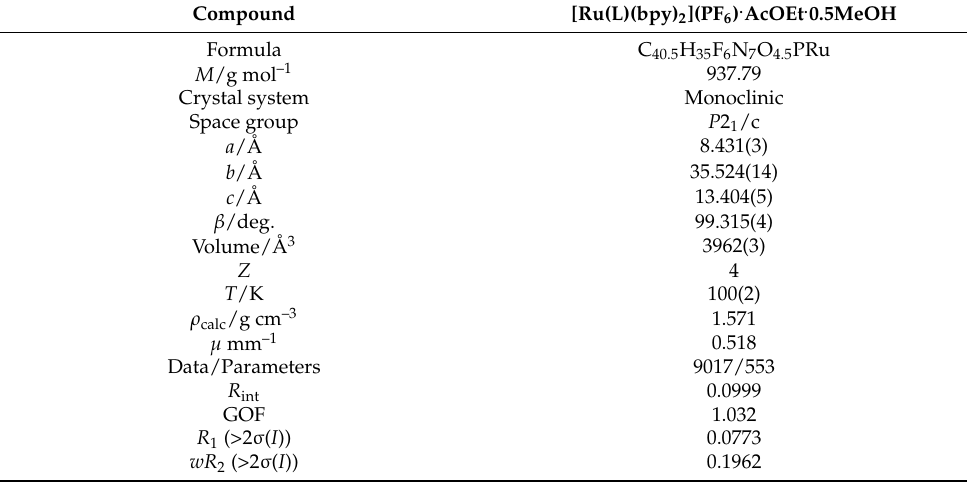
Figure 1. ( a ) A chemical structure of the complex cation in 1 . The PF 6− counter ion is omitted. ( b ) An ORTEP representation of the complex cation in 1 . All H atoms and solvent molecules were removed for clarity. Selected bond lengths: Ru–N1 2.076(5), Ru–N2 2.079(6), Ru–N4 2.044(6), Ru–N5 2.049(5), Ru–N6 2.047(6), and Ru–N7 2.050(5) Å. Table 1. X-ray crystallographic data for complex 1 .